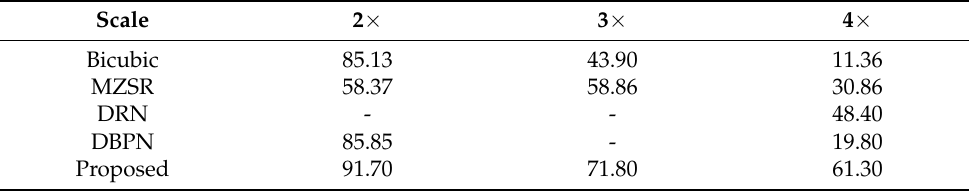
Table 5. Average mAP (%) comparison of LR license plates for validation of 10 classes (0–9). Scale